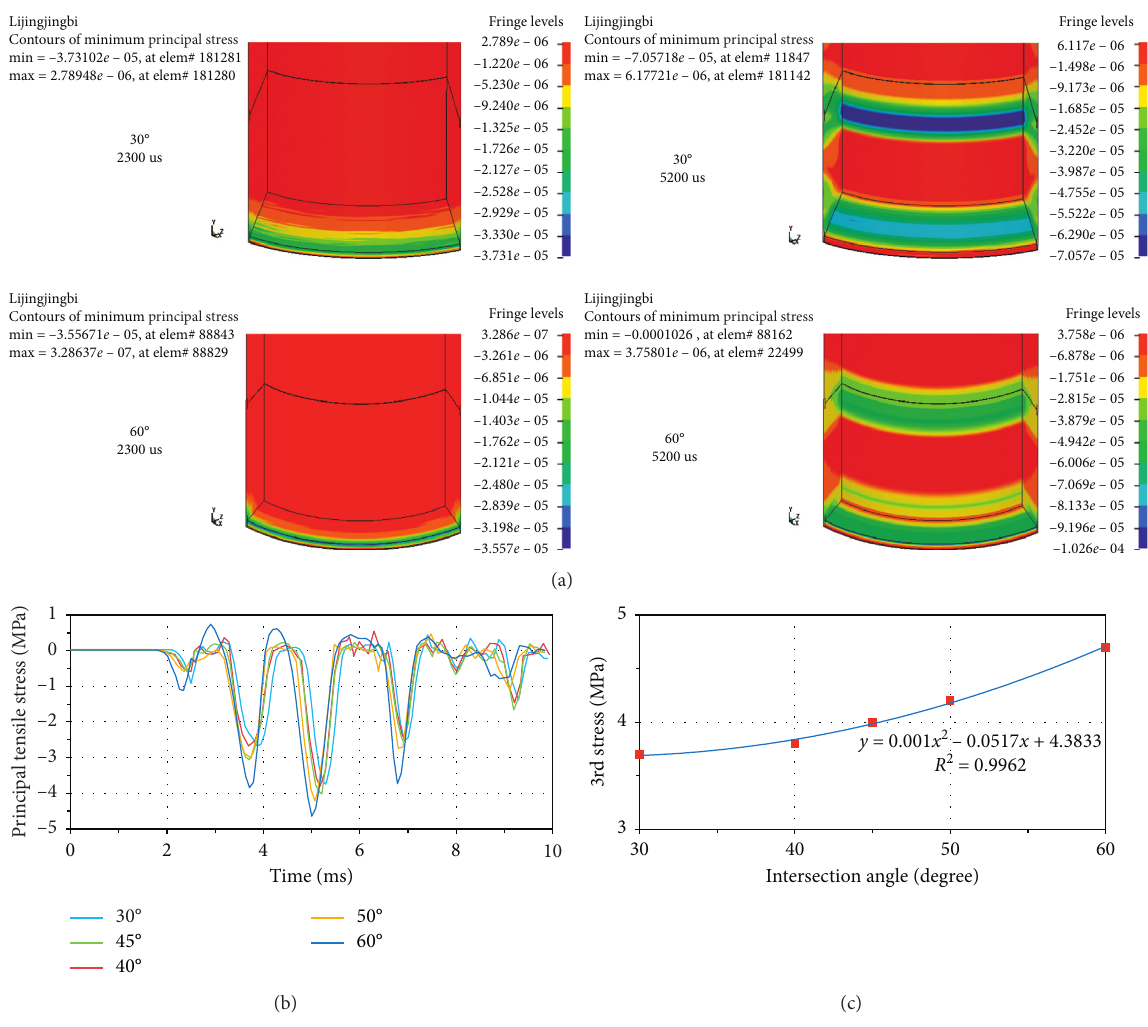
Figure 12: Relationships between the tensile stress in SPRC structures and joint angles. (a) Nephogram of the principal tensile stress at the center of the steel plate. (b) Tensile stress curves with different joint angles between two steel plates. (c) Fitting curves between the maximum tensile stress and joint